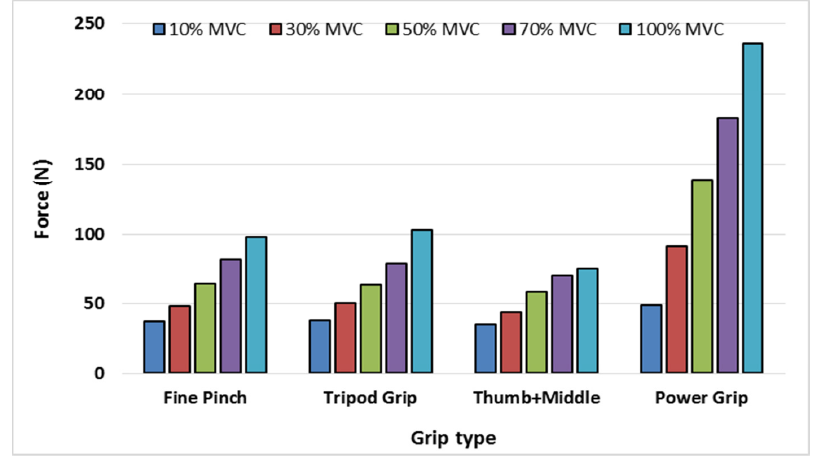
Fig. 8. Mean of the force measurements in newton (N) for 5 subjects with different grips for different levels of %MVC (i.e. 10, 30, 50, 70 and 100%